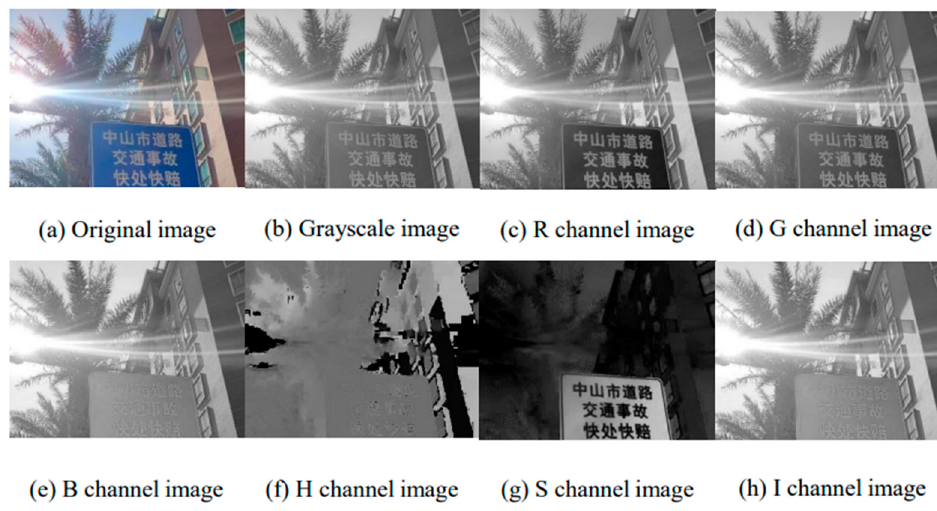
Figure 2. Image extraction results for different color channels.